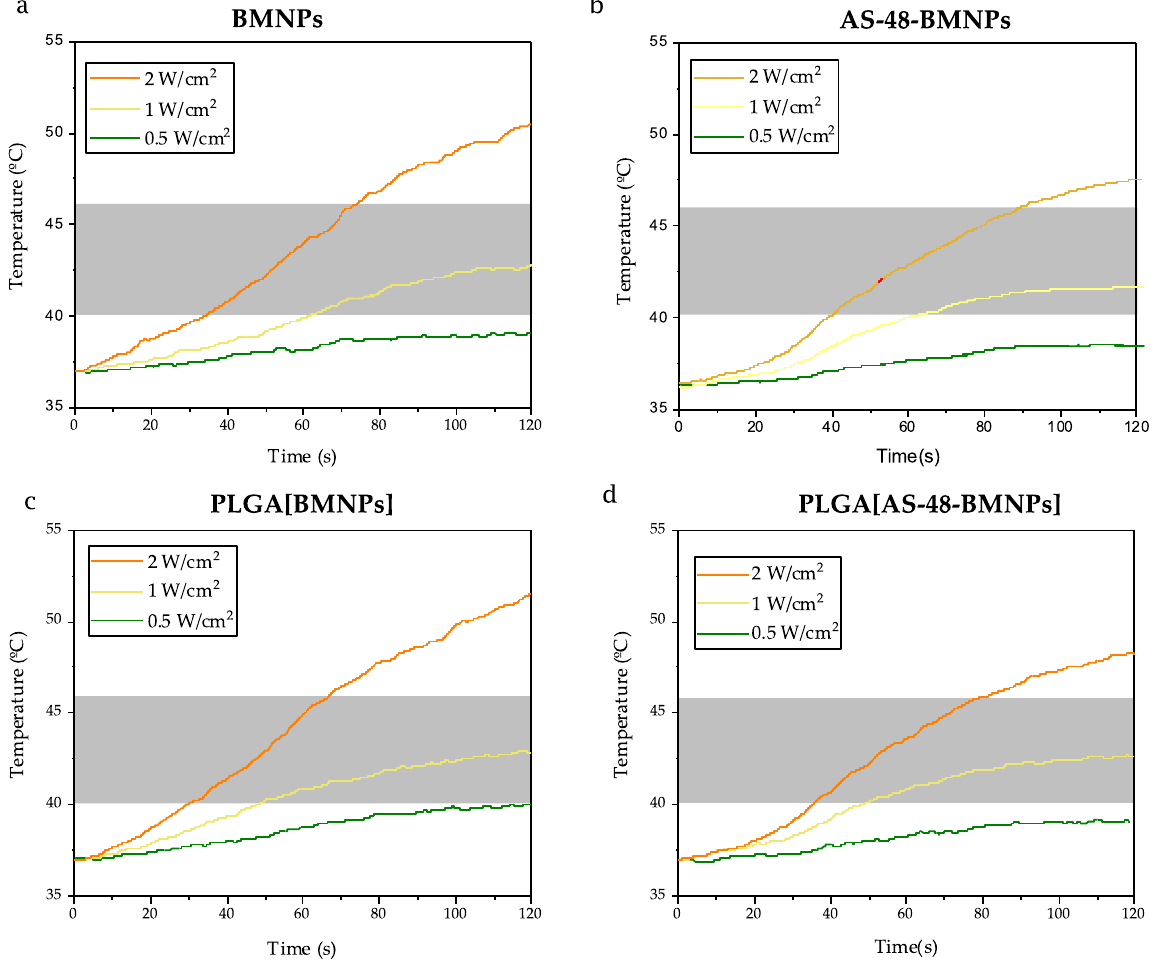
Figure 5. Time evolution of the temperature increase caused by ( a ) BMNPS, ( b ) AS-48-BMNPs, ( c ) PLGA[BMNPs], and ( d ) PLGA[AS-48-BMNPs] following exposure to different laser power densities (0.5, 1, 2 W/cm 2 ). The transparent grey band shows the therapeutic temperature.